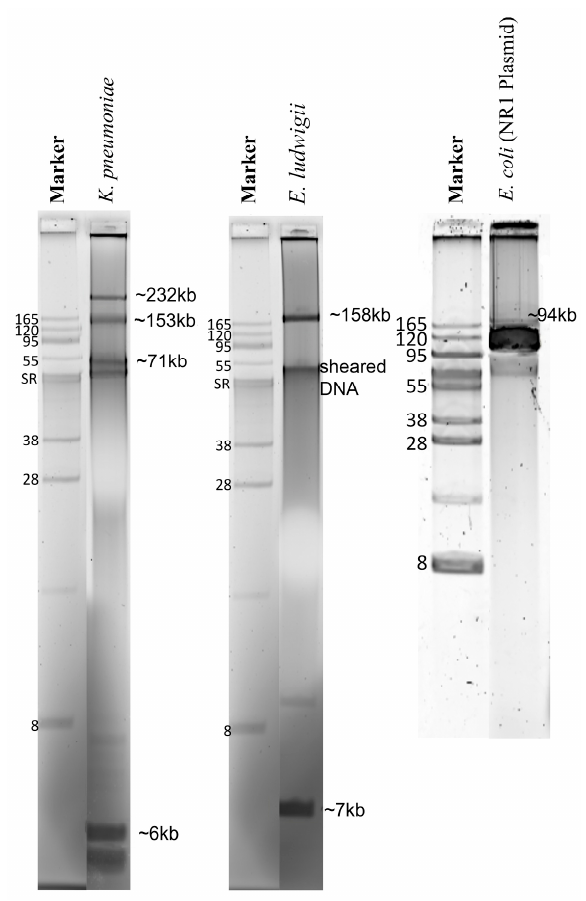
Figure 1. Agarose electrophoresis of plasmids from three enterobacteria sequenced in this study. The gel used is 0.5% SeaKem Gold agarose stained with SyberGreen. Plasmid molecular weight (kilobases = kb) was estimated using semi-log plotting based on DNA-band sizes observed in the agarose gel electrophoresis. Strains: Klebsiella pneumoniae —LST1504-C2, Enterobacter ludwigii — LST1391B, and Escherichia coli —DU1040 (NR1) plasmid control.